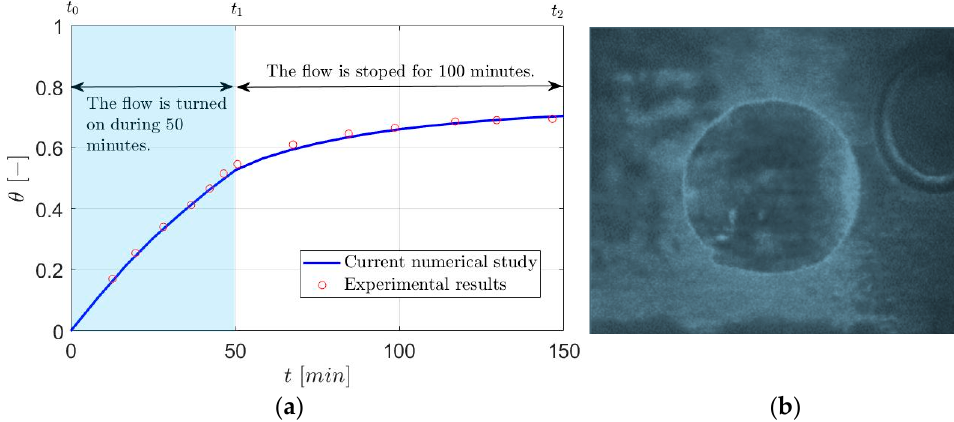
Figure 2. The time-dependent solution from the beginning of the test ( 𝑡 (cid:2868) ) to 50 min ( 𝑡 (cid:2869) ), and 150 min ( 𝑡 (cid:2870) ) [28].